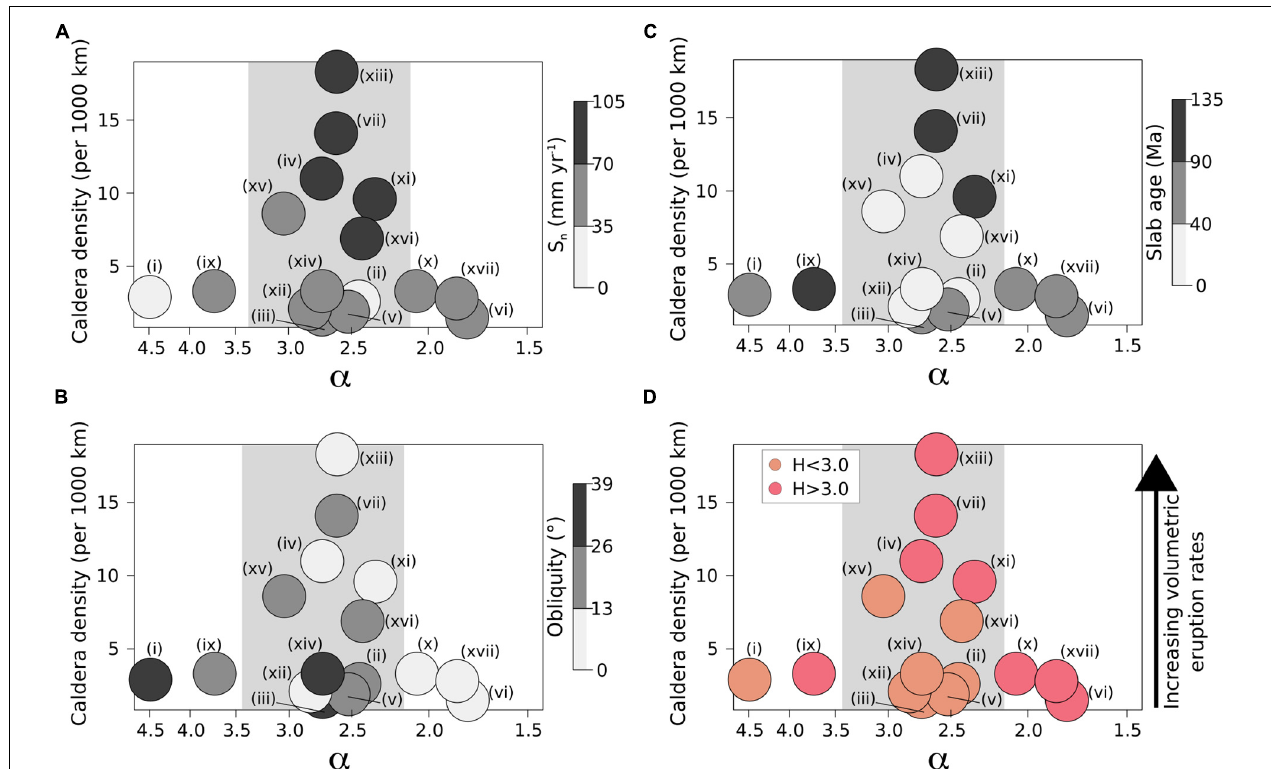
FIGURE 11 | The distribution of the power-law slope parameter ( α ) versus the density of calderas in each volcanic arc (defined as the number of calderas per 1000 km; Hughes and Mahood, 2008). Values of α between 2.2 and 3.2 are characterized by the complete ranges of caldera densities, whereas extremes in α are only characterized by low caldera density. Arcs with high caldera density are characterized by (A) the highest rates of subduction normal to the arc. These high caldera density regions are also characterized by (B) low obliquity and (C) older slab ages. (D) Hence, for the arcs with α between 2.2 and 3.2, increasing caldera density is associated with a transition from a low-H regime to a high-H regime. Arcs are labeled as follows: (i) Antilles, (ii) Cascades, (iii) C. Aleutians, (iv) C. America, (v) C. Andes, (vi) E. Aleutians, (vii) Hokkaido-Kuriles, (ix) Izu-Bonin, (x) Java-Bali, (xi) Kamchatka-Kuriles, (xii) Mexico, (xiii) NE. Japan, (xiv) N. Andes (xv) Ryuku, (xvi) S. Andes, and (xvii) W. Alaska. Honshu is not included in the analyses by Hughes and Mahood, 2008, and is therefore not